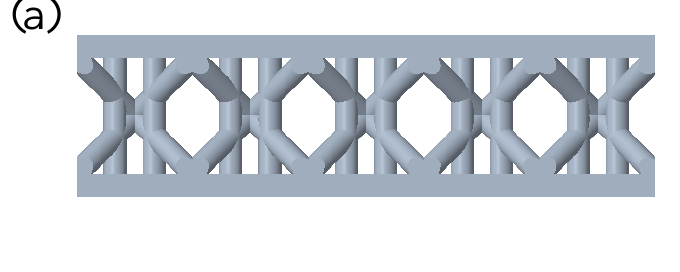
Figure 6. The deformation of a unit cell in the horizontal plane.